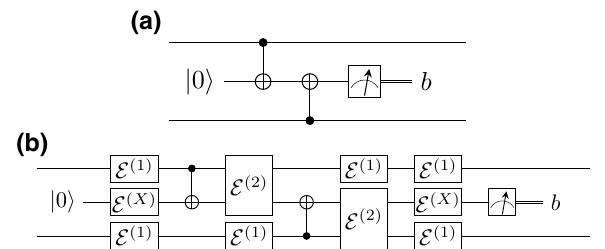
FIG. 4. (a) Example of an ideal circuit to measure weight-two operator ZZ . We assume that every gate, as well as prepara- tion and single-qubit measurements take one time unit. (b) The noisy circuit is modeled with ideal gates followed by the depo- larizing channel of strength p ; ideal preparation can fail and produce a state orthogonal to the desired one with probability p , and the outcome of the ideal measurement can be flipped with probability p